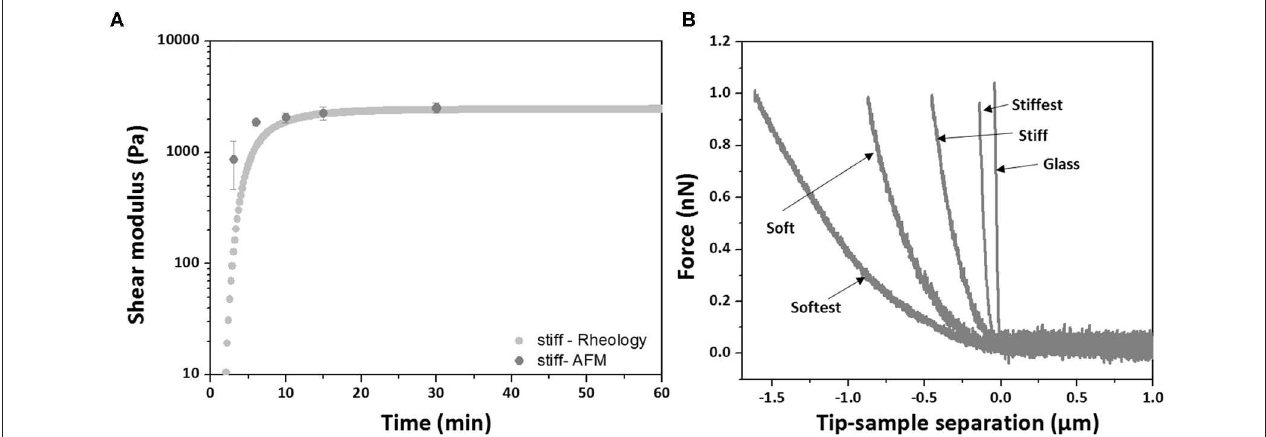
FIGURE 2 | (A) Comparison of elastic modulus during polymerization between in situ bulk shear rheology (dotted curve) and AFM measurements (data points are averaged over three samples, whiskers indicate SD) for stiff hydrogel. (B) Typical AFM force-distance curves obtained for each hydrogel composition after polymerization at Day 0